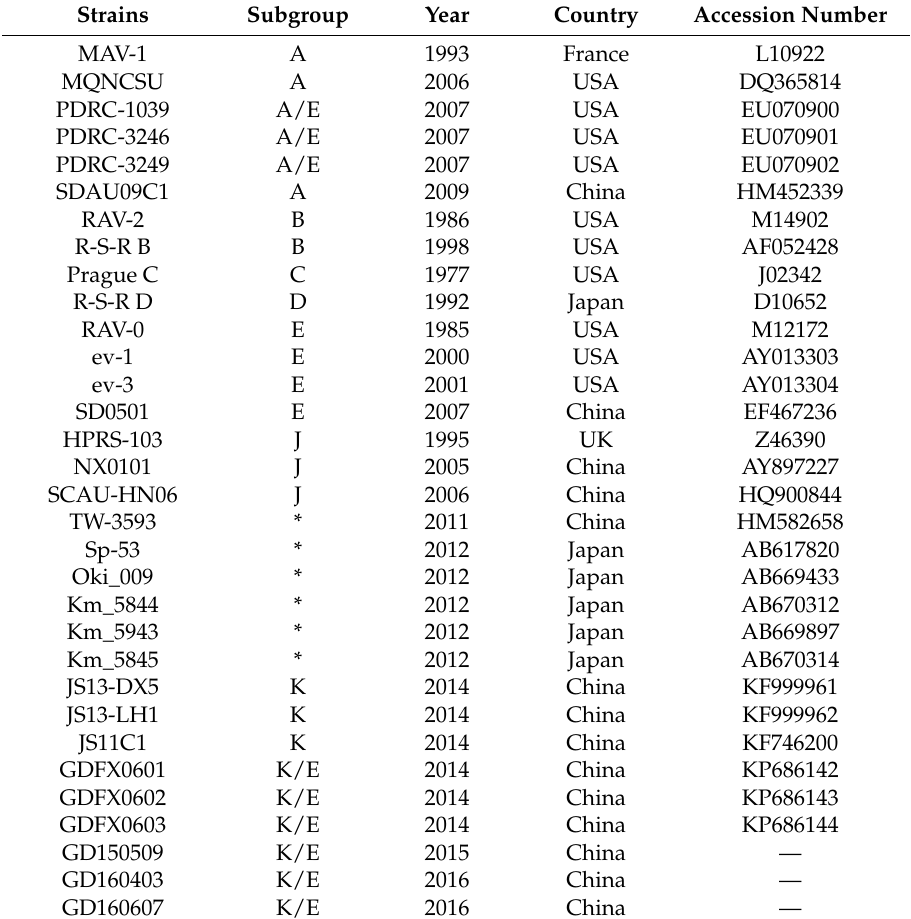
Table 2. ALV reference strains used in this